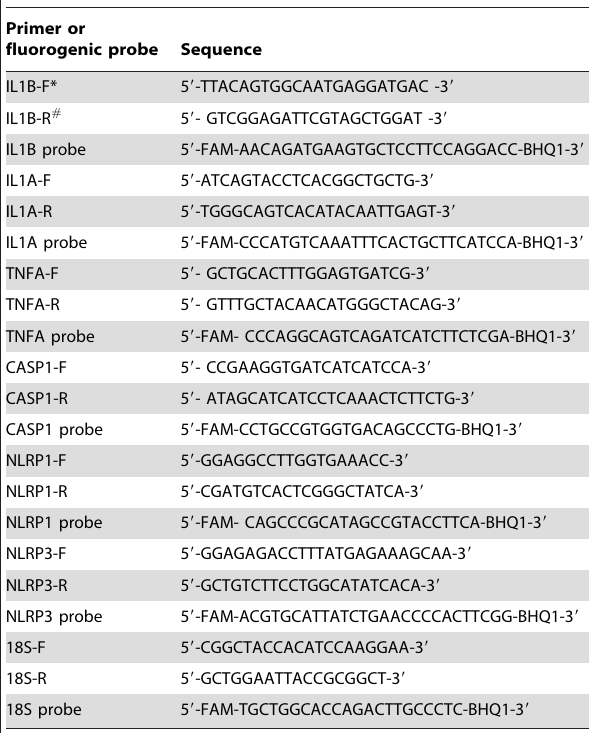
Table 1. Primers and probes used in quantitative real-time